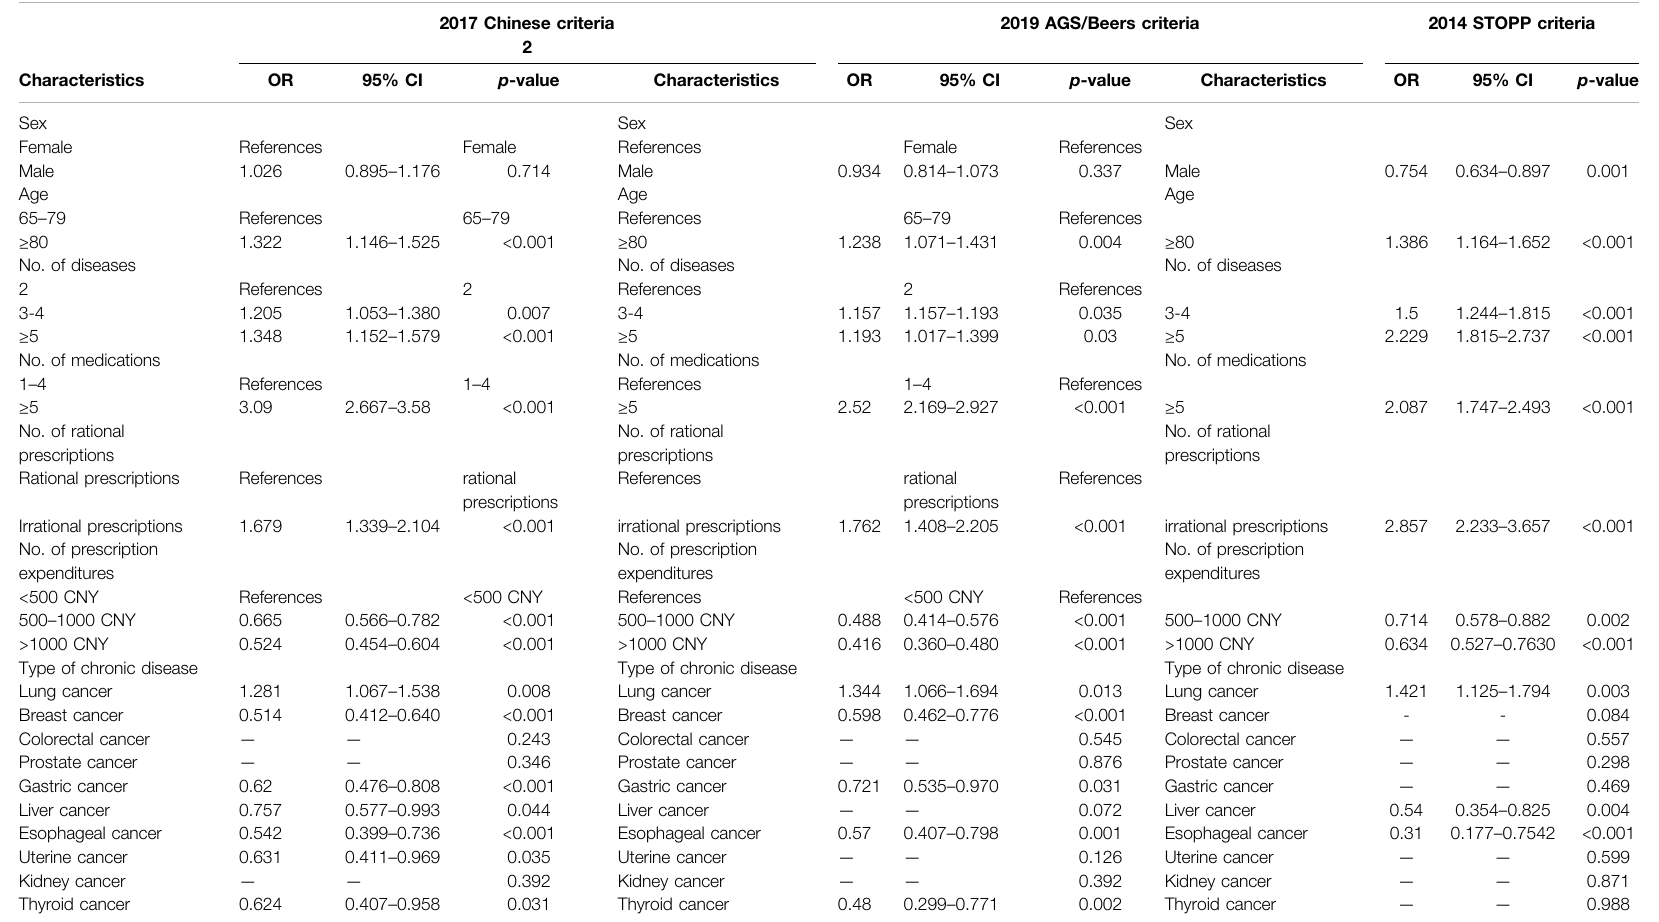
TABLE 5 | Multivariate logistic regression analysis of factors associated with PIM